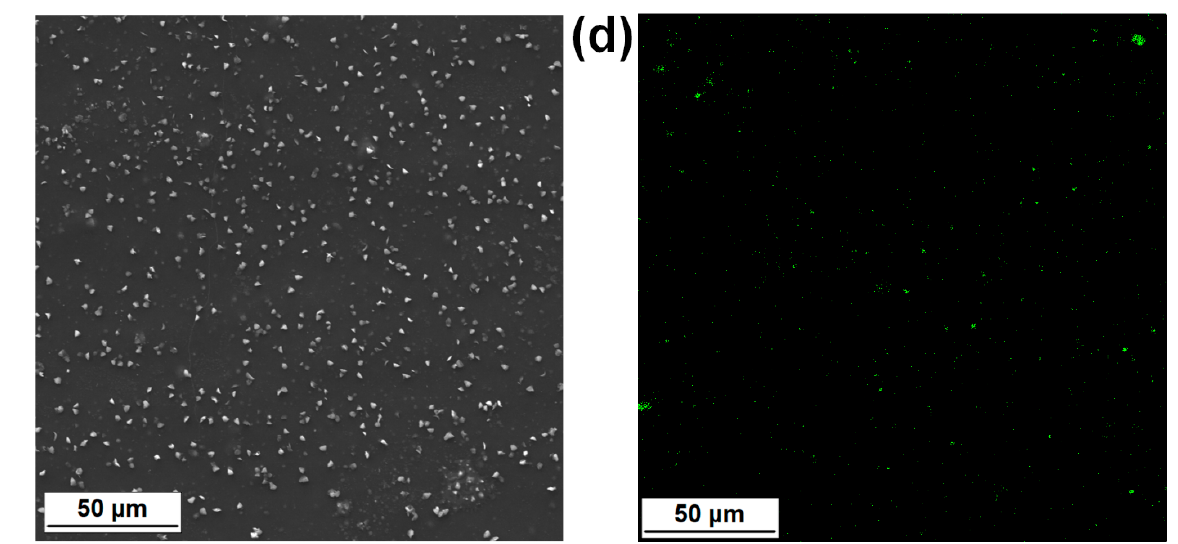
Materials 2021 , 14 , x FOR PEER REVIEW Figure 7. Representative SEM-EDS images of magnesium mapping: ( a ) LDPE/MgO, ( b ) LDPE/MgO-L (5:1 wt/wt), ( c ) LDPE/MgO-L (1:1 wt/wt), and ( d ) LDPE/MgO-L (1:5 wt/wt).